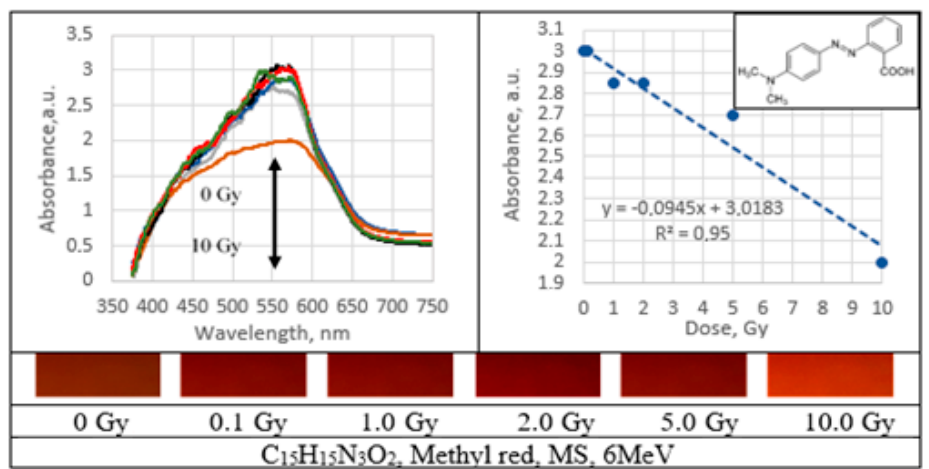
Figure 4. Absorbance spectra and sensitivity of the irradiated methyl red films.